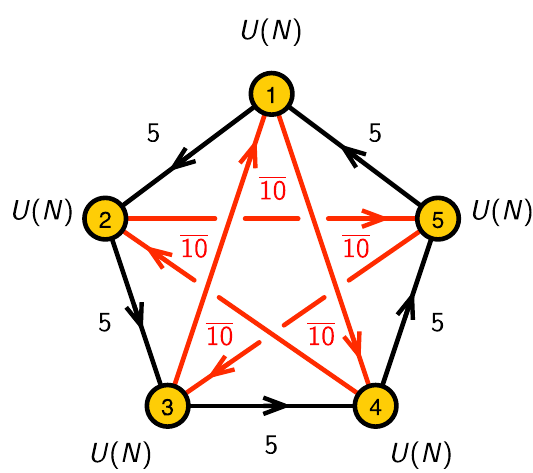
Figure 13 . Quiver diagram for local CP 4